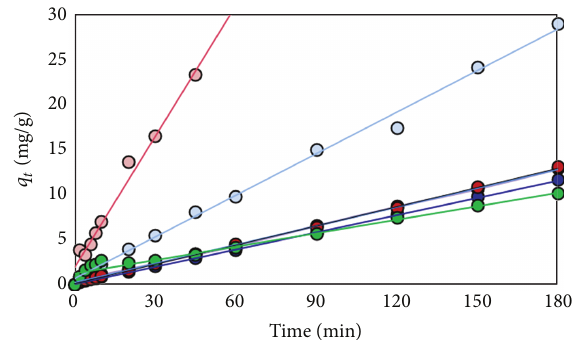
Figure 12: Plot of 𝑡/𝑞 𝑡 of Cr 3+ versus time for effect of different kindsofvariousadsorbents(RS(lightblue),RS-oil3hr(purple),RS- NaOH 450 W (blue), Bagasse (pink), Bagasse-NaOH 600W (red), and Dowax